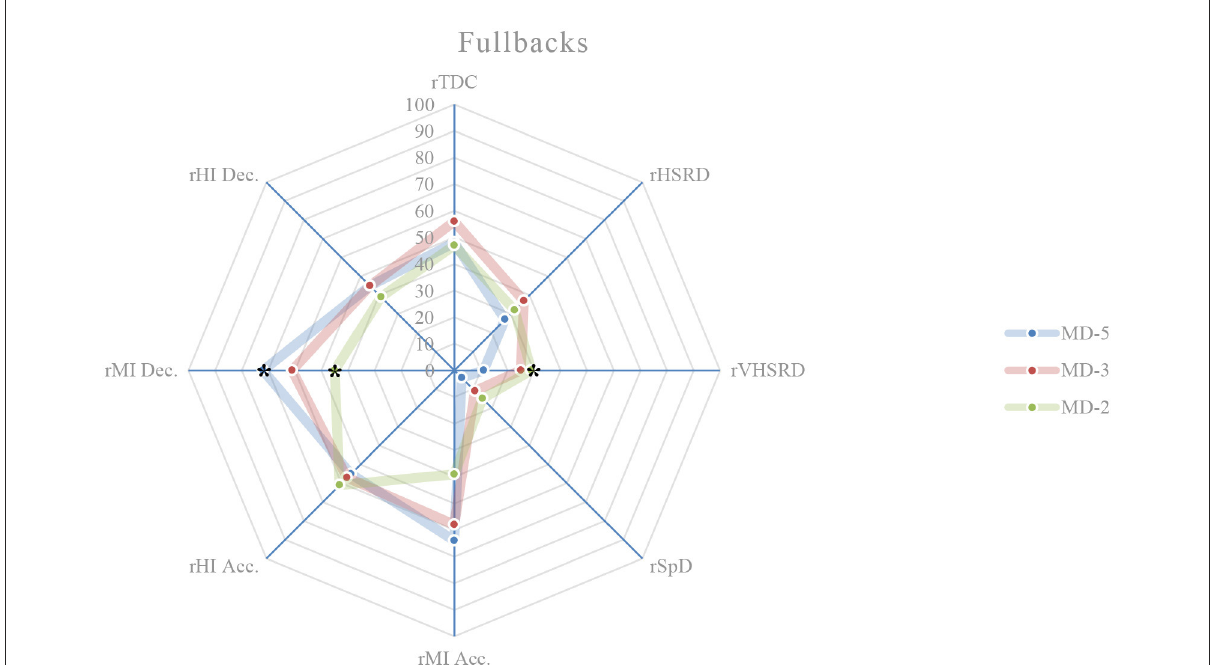
FIGURE2 Daily external load (based on MRef) of fullbacks. *Location of the significant differences, p <